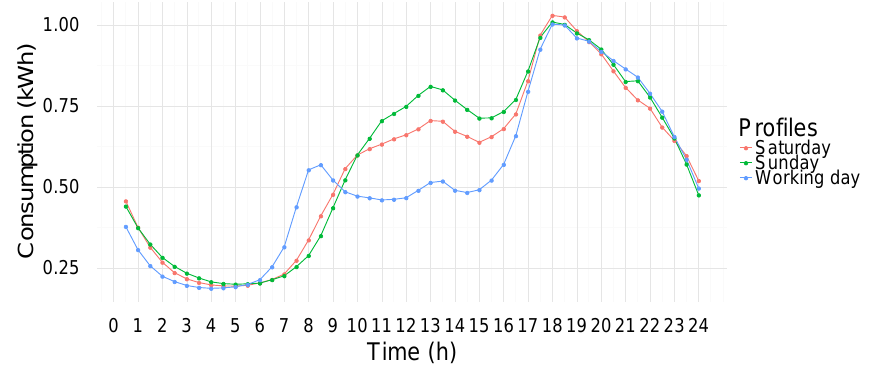
Figure 1. Average electricity consumption of residential consumers obtained for the three day types (Saturday, Sunday and weekday) during